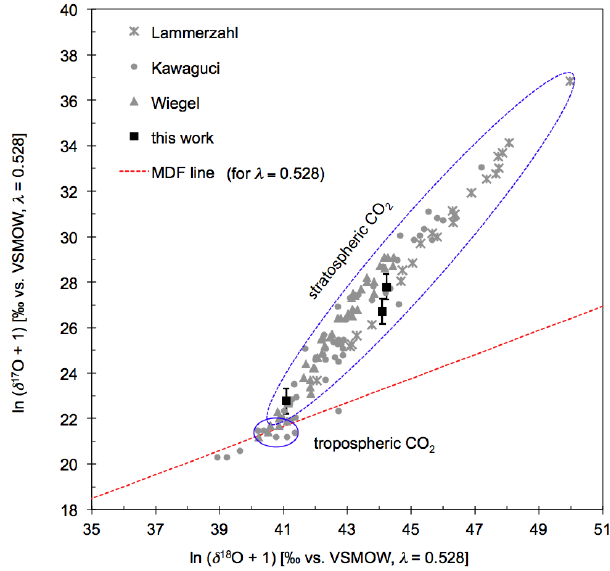
Figure 9. Three-isotope plot for oxygen isotopes in CO 2 from at- mospheric air samples. Previous observations are from Kawagucci et al. (2008) (circles); Lämmerzahl et al. (2002) (diamonds) and Wiegel et al. (2013) (triangles). Three samples from the RECON- CILE project (squares) fall in the range of previously published val- ues. Two blue circles distinguish tropospheric air samples (contin- uous blue circle) from stratospheric ones (dashed blue circle). The red line is the mass dependent fractionation line with slope 0.528. Note logarithmic scale ln 17 O = ln( δ 17 O + 1) and ln 18 O = ln( δ 18 O +